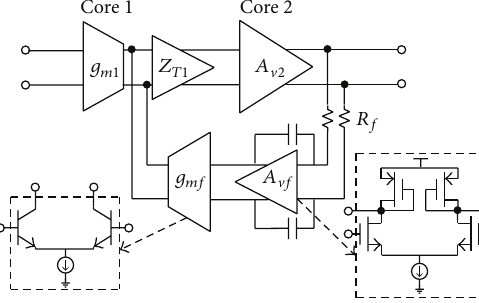
Figure 9: Block diagram of DC offset correction circuit.